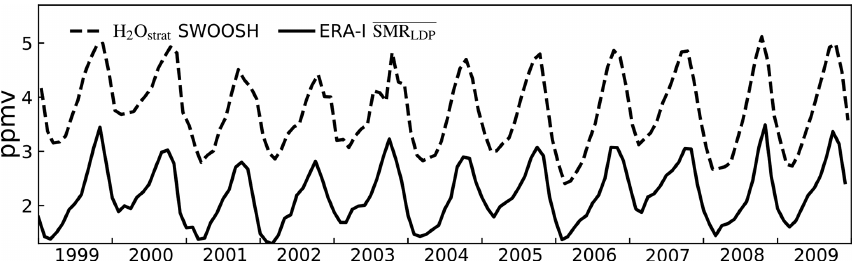
Figure 1. Time series over 1999–2009 of monthly mean zonal mean of water vapour in the tropics (30 ◦ N–30 ◦ S) at 83hPa in SWOOSH (Davis et al., 2016) and Lagrangian dry point (LDP) estimates of water vapour entering the stratosphere based on ERA-Interim diabatic back trajectories.